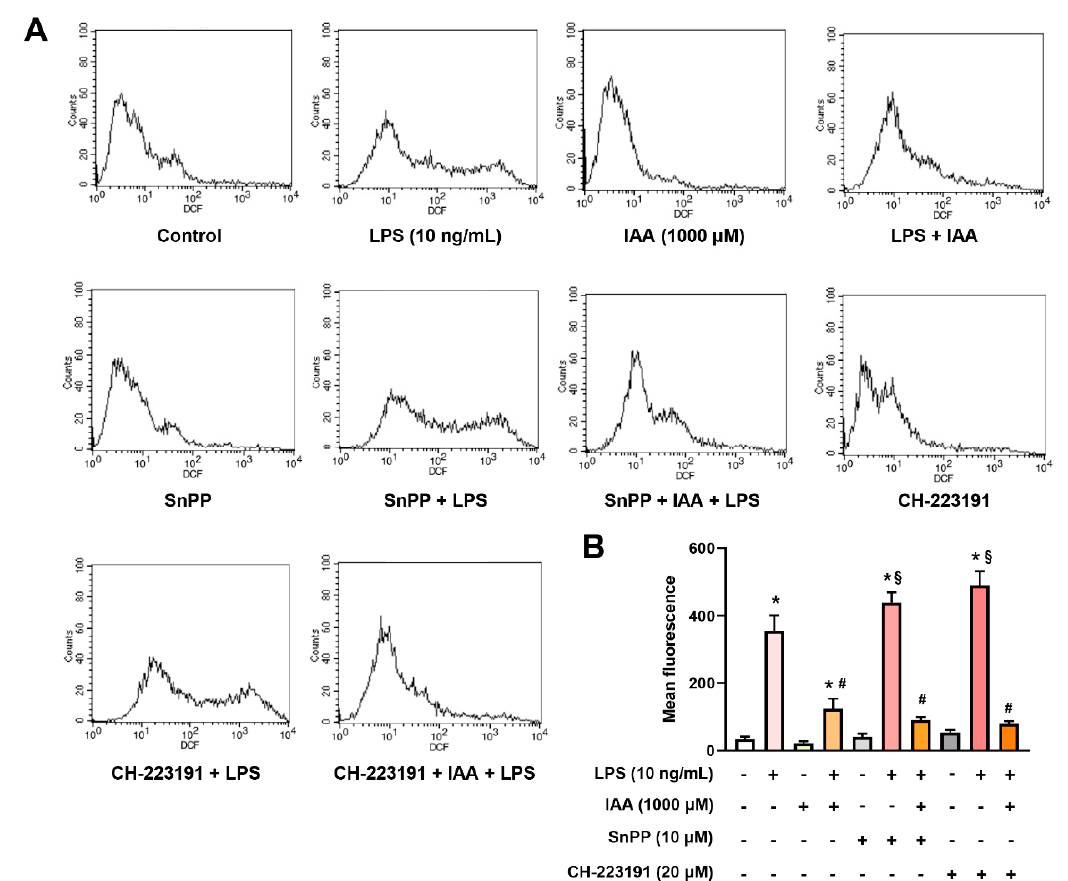
Figure 7. Effects of SnPP and CH-223191 on the scavenge of ROS by IAA. ( A ) Representative flow cytometry plots. ( B ) Statistical results presented by bar chart. Cells were treated with IAA (1000 µM) with or without SnPP (10 µM) or CH-223191 (20 µM) for 12 h, followed by LPS (10 ng/mL) exposure for 16 h in the presence or absence of IAA plus SnPP or CH-223191. DCFH-DA probe was added to detect the ROS level. Results are shown as mean ± SEM. n = 3. * p < 0.05 versus control group. # p < 0.05 versus LPS group. § p < 0.05 versus corresponding group without SnPP and CH-223191. DCFH-DA, 2 ′ ,7 ′ -dichlorofluorescin diacetate; ROS, reactive oxidative species; SnPP, tin protoporphyrin IX; IAA, Indole-3-acetic acid; LPS, lipopolysaccharide.